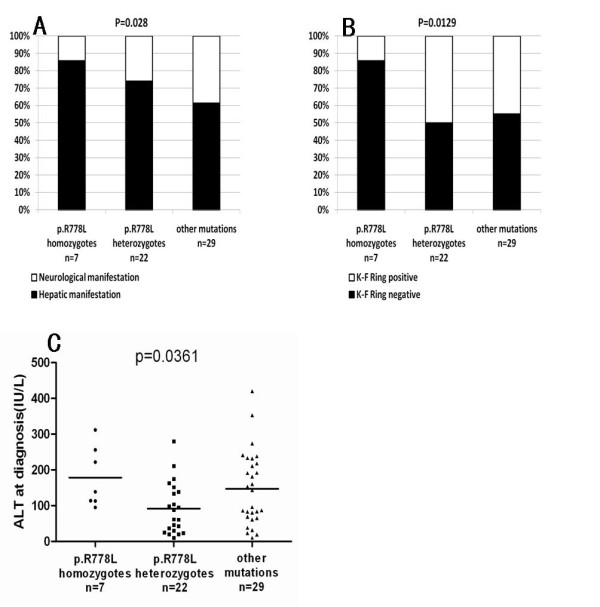
Correlation of p.Arg778Leu mutation with clinical manifestations (A), cornea Kayser-Fleischer ring rate (B) and ALT levels at diagnosis (C).